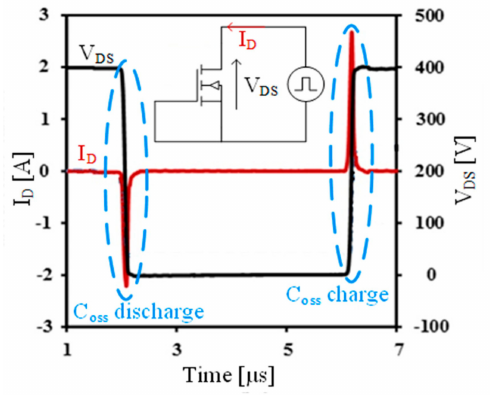
Figure 3. Auriga pulsed I–V tests: I D and V DS waveforms.